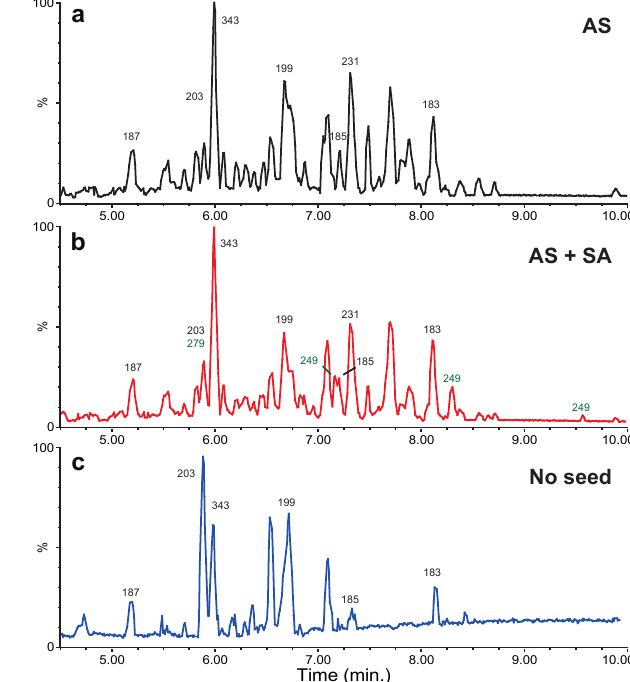
Fig. 5. UPLC/(-)ESI-TOF chromatograms from the filter samples of low-NO x photooxidation of α -pinene or pinonaldehyde, (a) α - pinene in the presence of AS seed particles (3-H2O2) (b) α -pinene in the presence of AS+SA seed particles (5-H2O2) and (c) pinon- aldehyde. Chromatographic peaks designated with black [ M − H ] − ions are carboxylic acids and chromatographic peaks designated with green [ M − H ] − ions are organosulfates. See Table 2 for com- pound